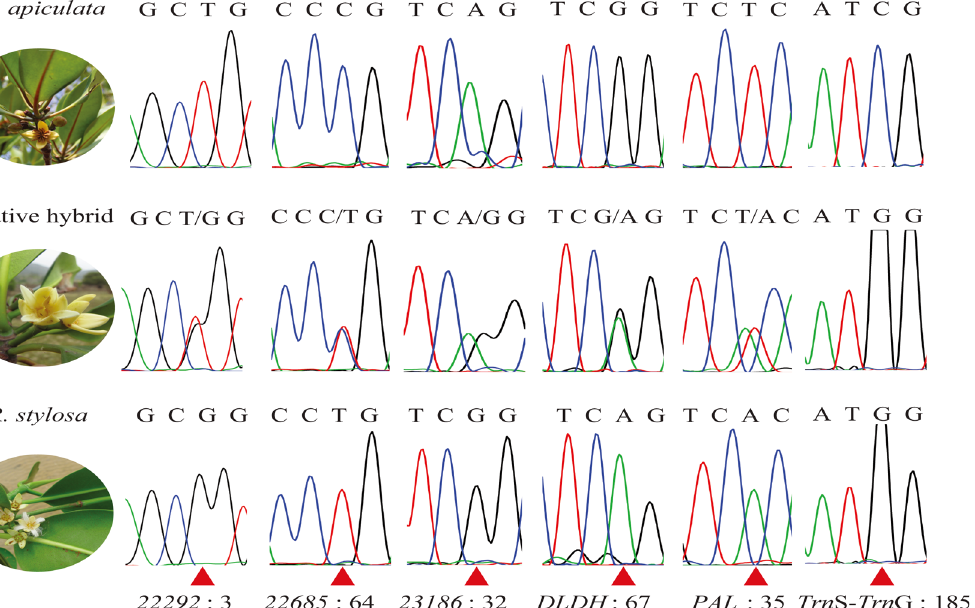
Fig 4. Chromatograms of the five nuclear genes and the chloroplast intergenic spacer in the three Rhizophora taxa in Hainan Island, China. Only one position for each locus is shown. The red triangles represent the variable sites between R . stylosa and R . apiculata , and the numbers after the colon represent the